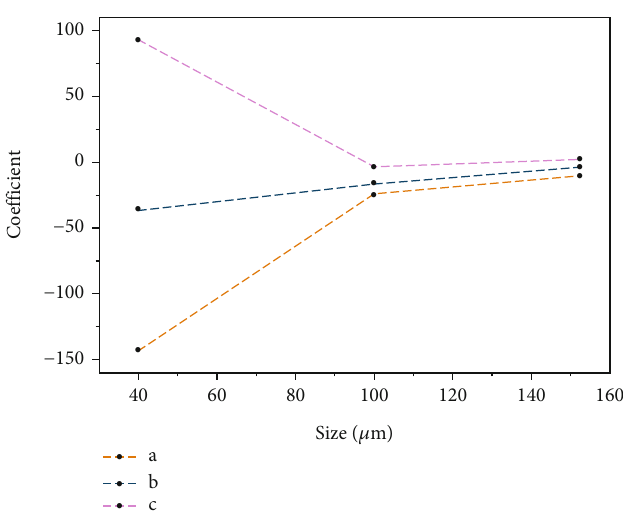
Figure 7: Relations between coe ffi cients a , b , c and particle size.